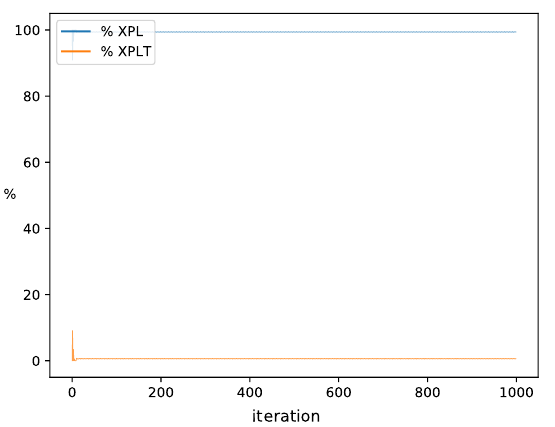
Figure 16. WOA—Exploration and Exploitation Graphic of instance d4 version